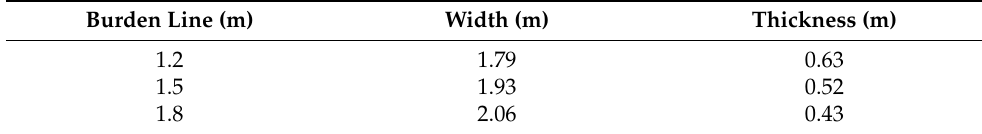
Figure 7. Shape of the burden surface of the ore-free zone at different burden line depths. Table 8. Width and thickness of the ore-free zone at different burden line depths.